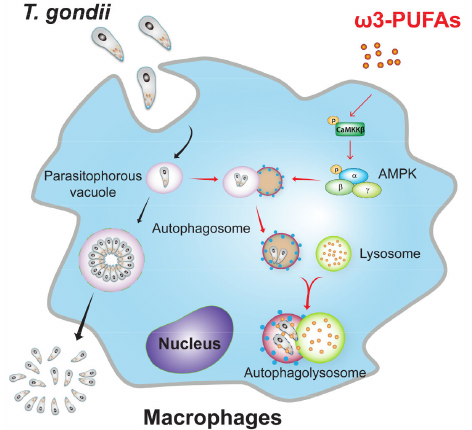
Figure 7. Schematic model representing the novel activities of ω 3-PUFAs against T. gondii infection. Endogenous enriched ω 3-PUFAs or the treatment of DHA induced CaMKK β / AMPK-dependent